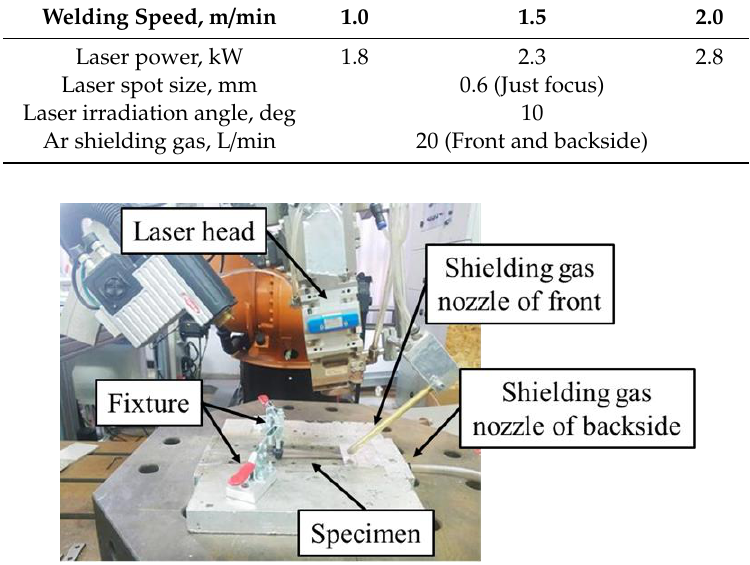
Figure 1. Experimental equipment and method.